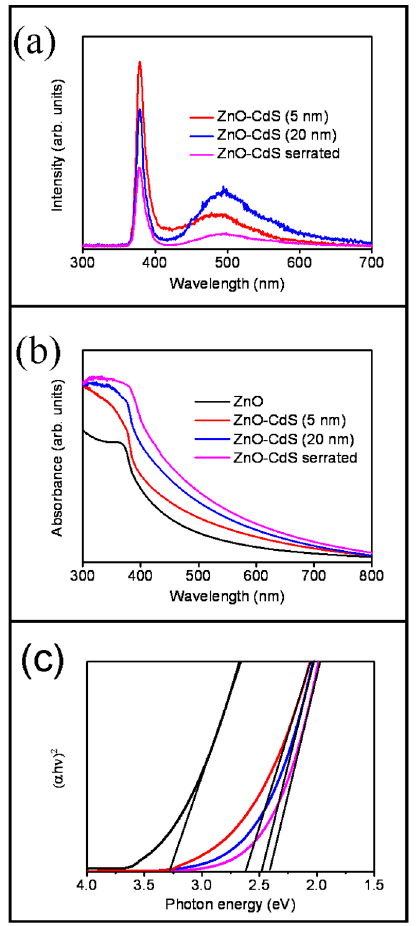
Figure 5. ( a ) PL(photoluminescence) spectra of the various ZnO-CdS nanorods; ( b ) Optical